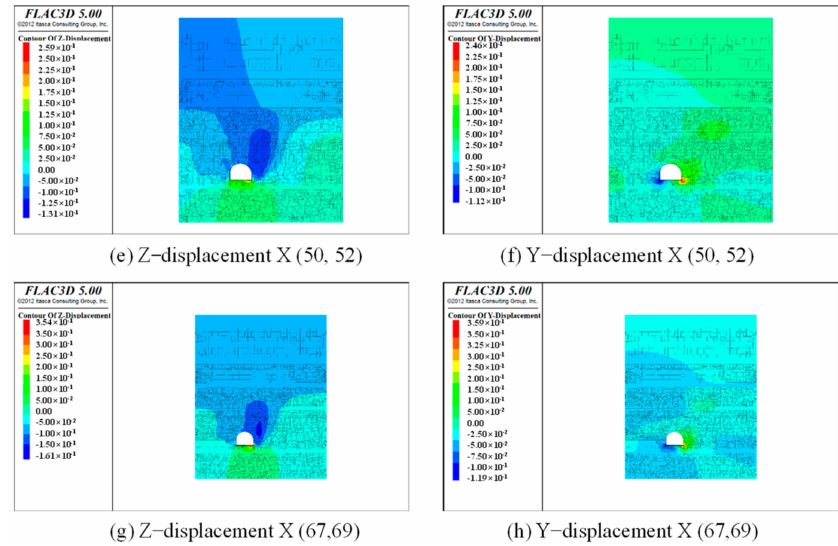
Figure 19. Main inclined shaft and supporting state without excavation